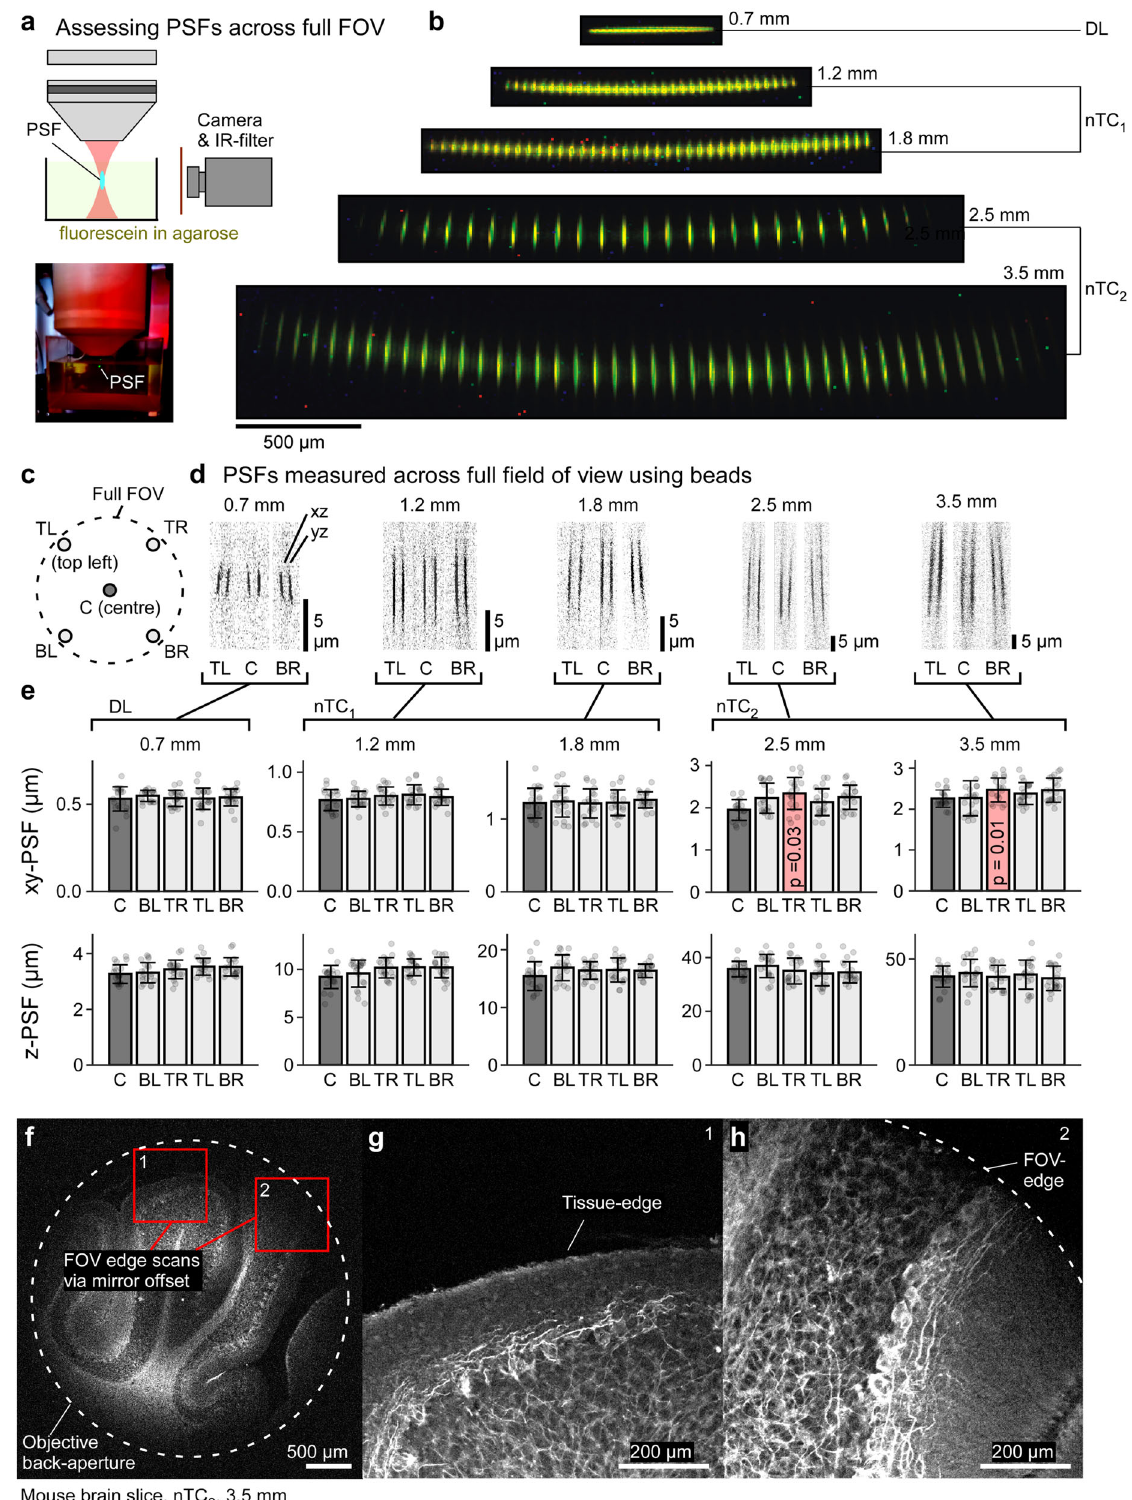
sub-micron DL PSF offered by typical collimated